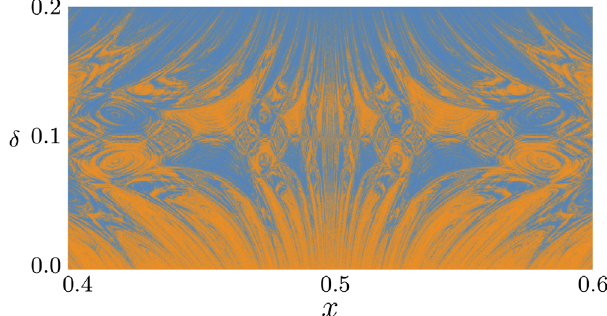
FIG. 11. Transversal section of the intermingled basins that directly connects the two symmetric subchimeras. This plot corresponds to a different state-space section of the system considered in Fig.